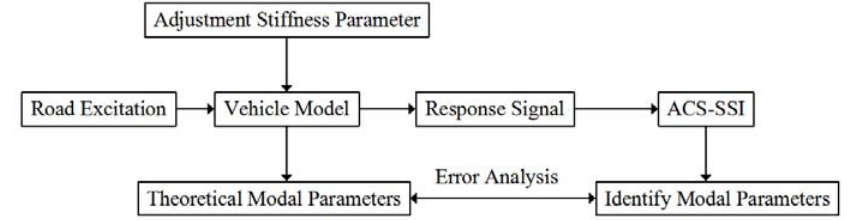
Figure 5. Schematic diagram of simulation analysis.